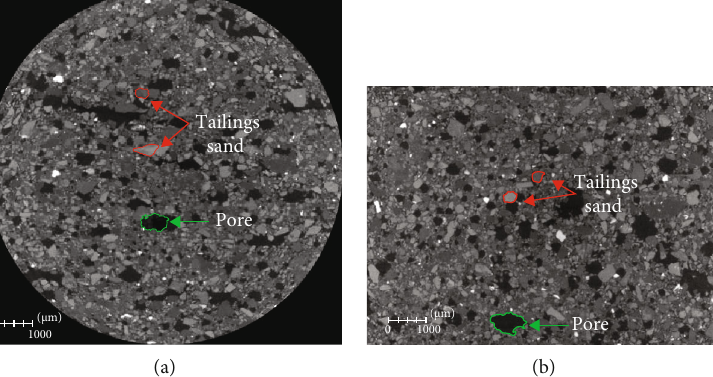
Figure 8: Two-dimensional section diagram of tailing sand sample: (a) x - y direction; (b) x - z